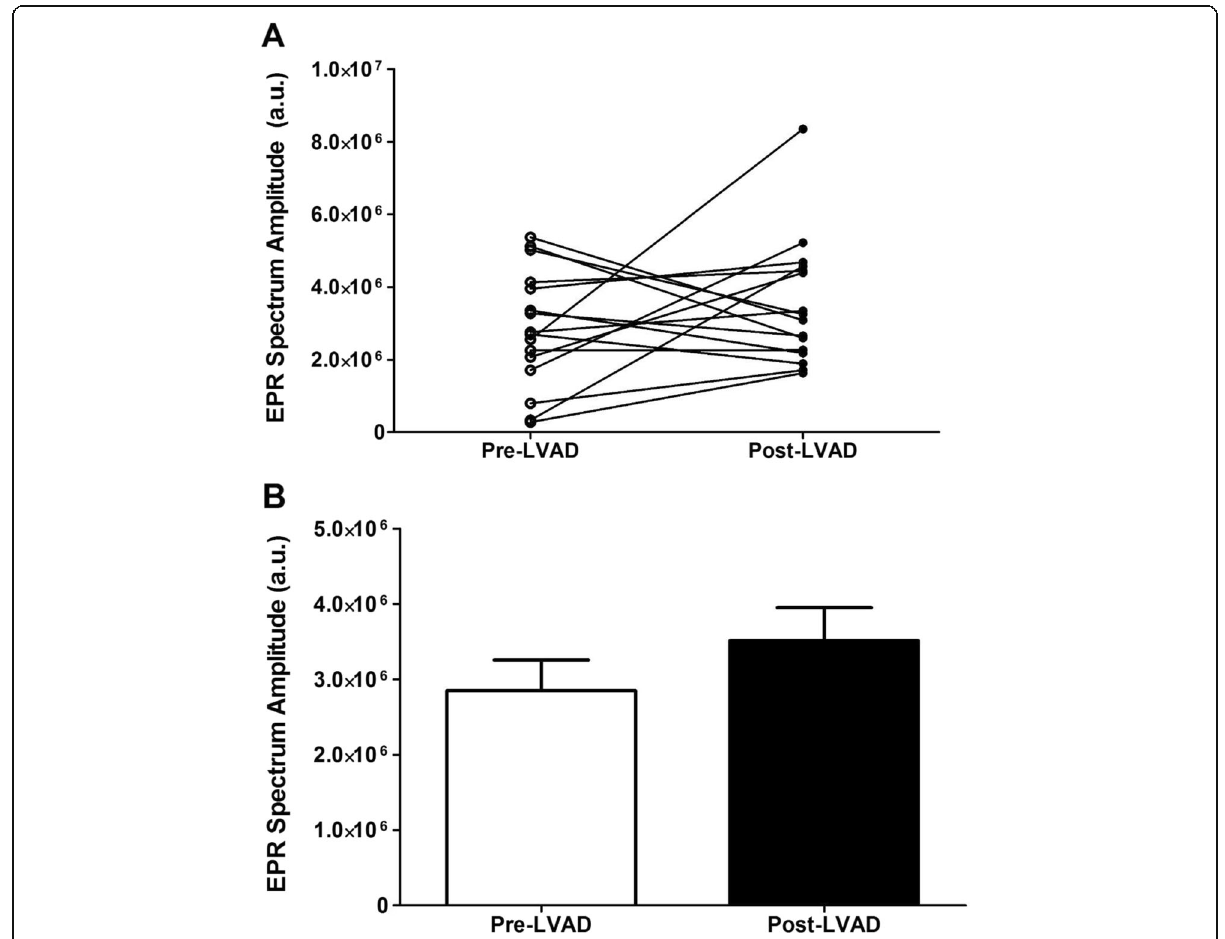
Fig. 3 Free radical levels in whole blood pre- and